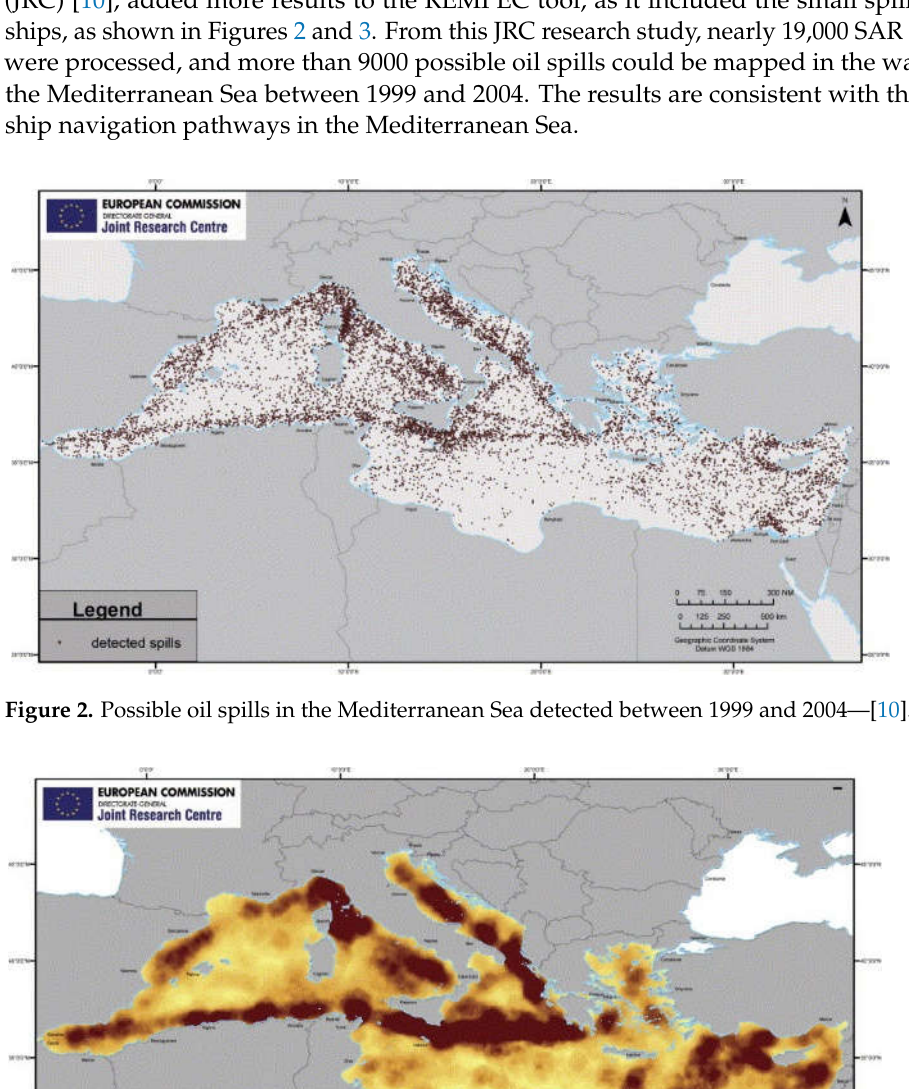
Figure 4. Possible oil spills detected near Cyprus from 2007–2011 [11]. 2. Materials and Methods 2.1. Study Area The area of study is the Mediterranean Sea coastal waters of Egypt from Port Said and the Suez Canal to Marsa Matruh. This area is occupied by the five major cities of